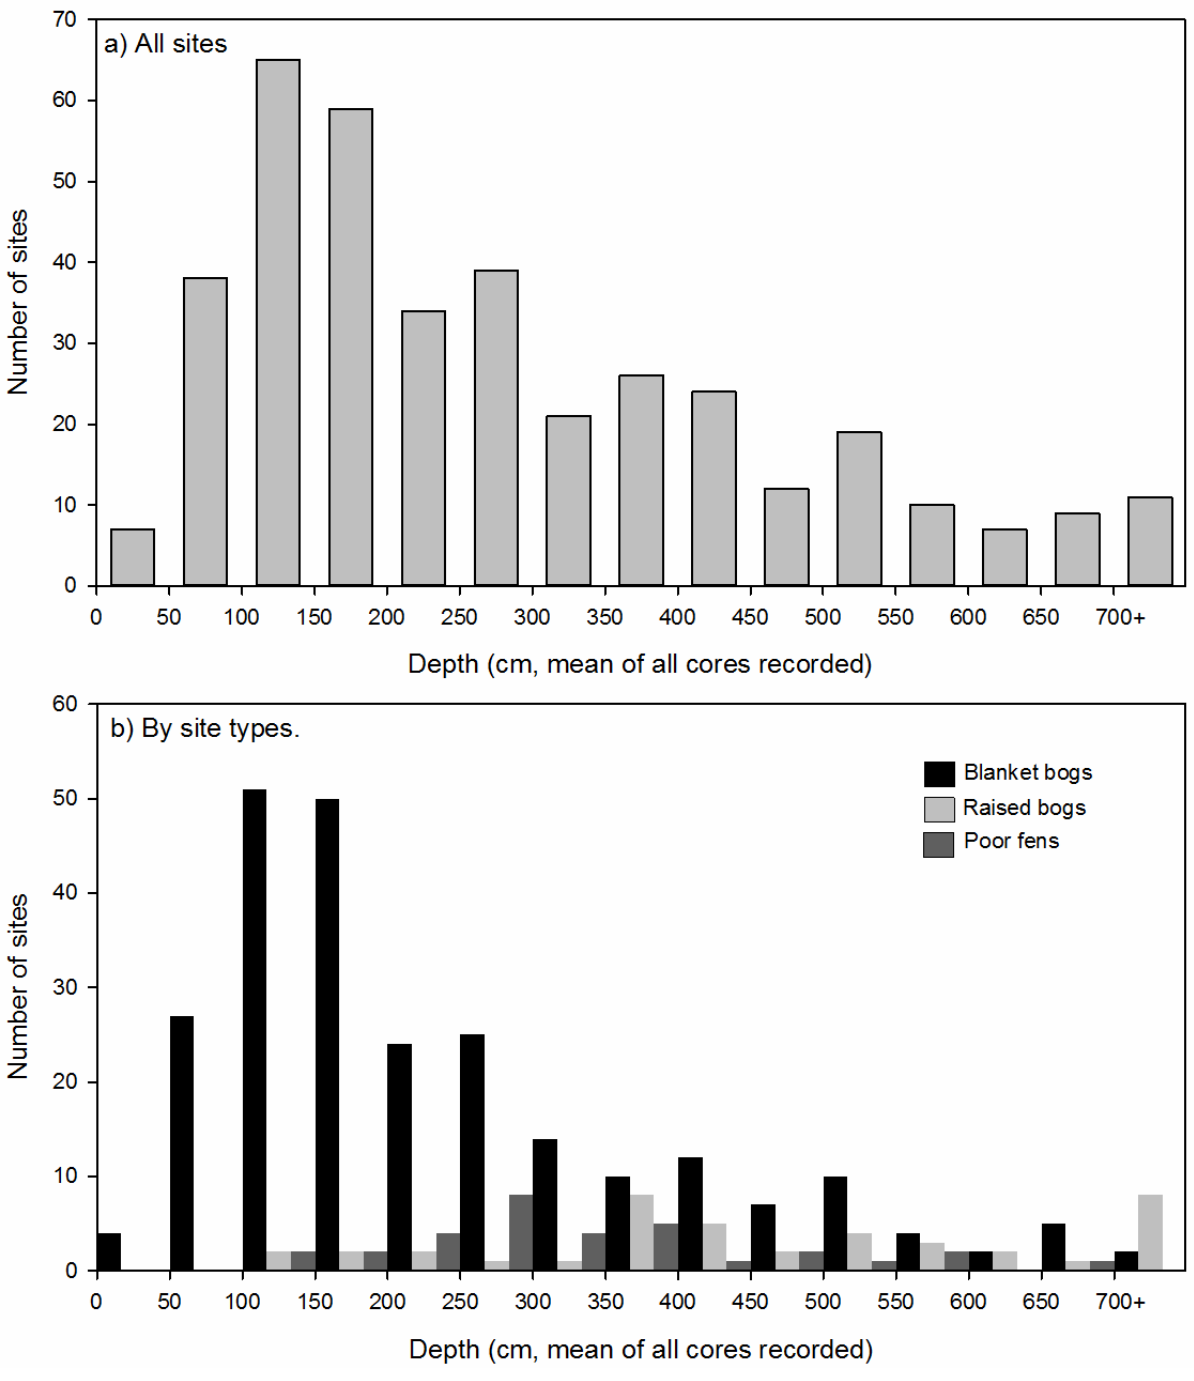
Figure 2. Peat depth from the palaeoecological depth dataset (Supplementary Material 1). A) All sites. B) Results broken down by site. Note that it was not possible to classify some peatlands on the basis of available